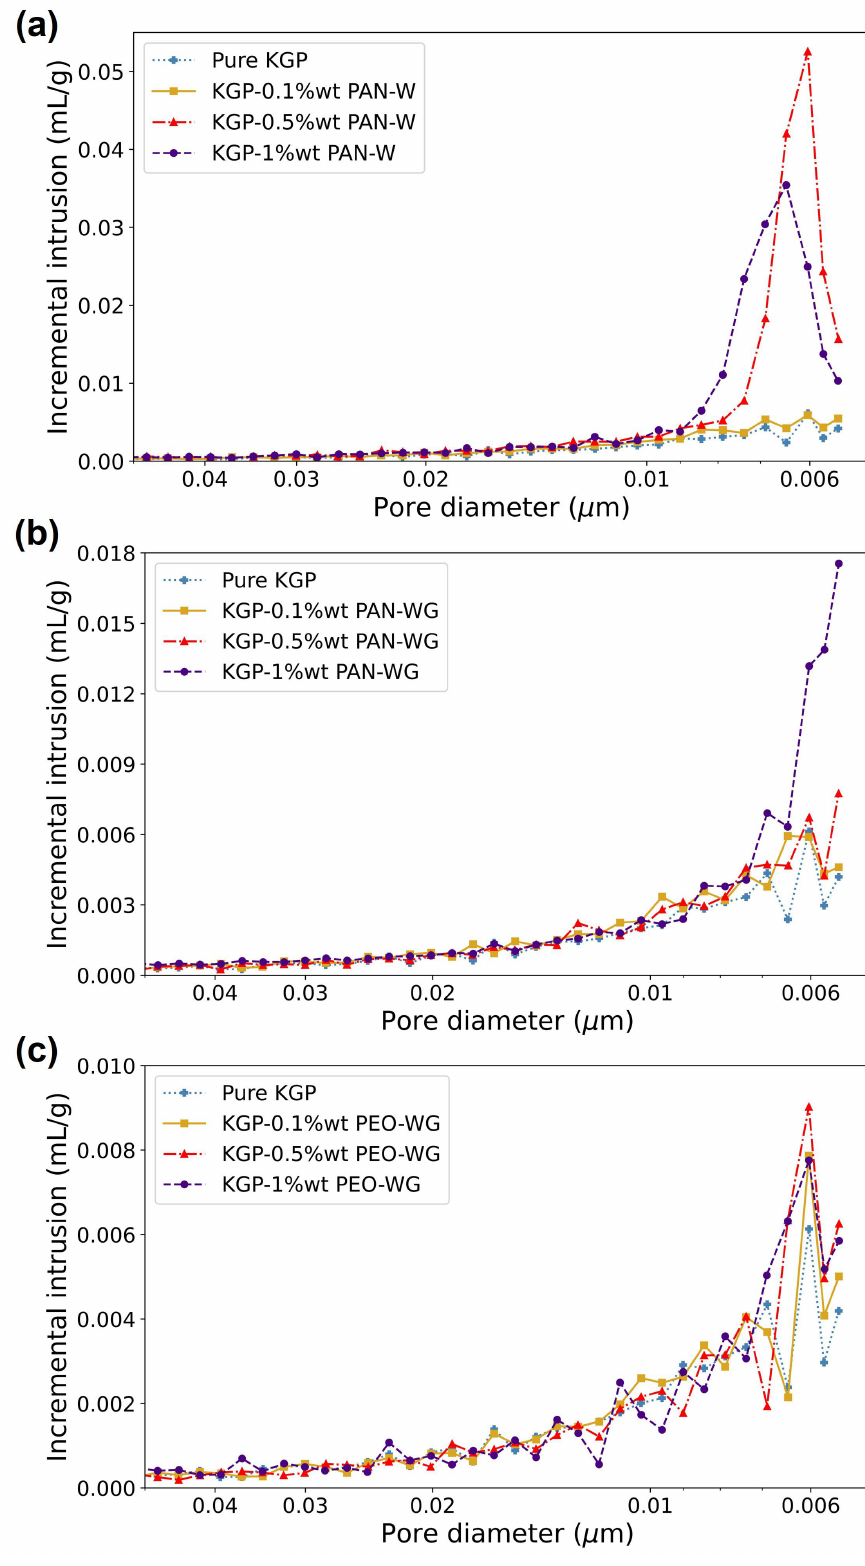
Figure 10. Incremental MIP results of electrospun-fiber-reinforced geopolymer composites: ( a ) KGP/PAN-W. ( b ) KGP/PAN-WG. ( c )